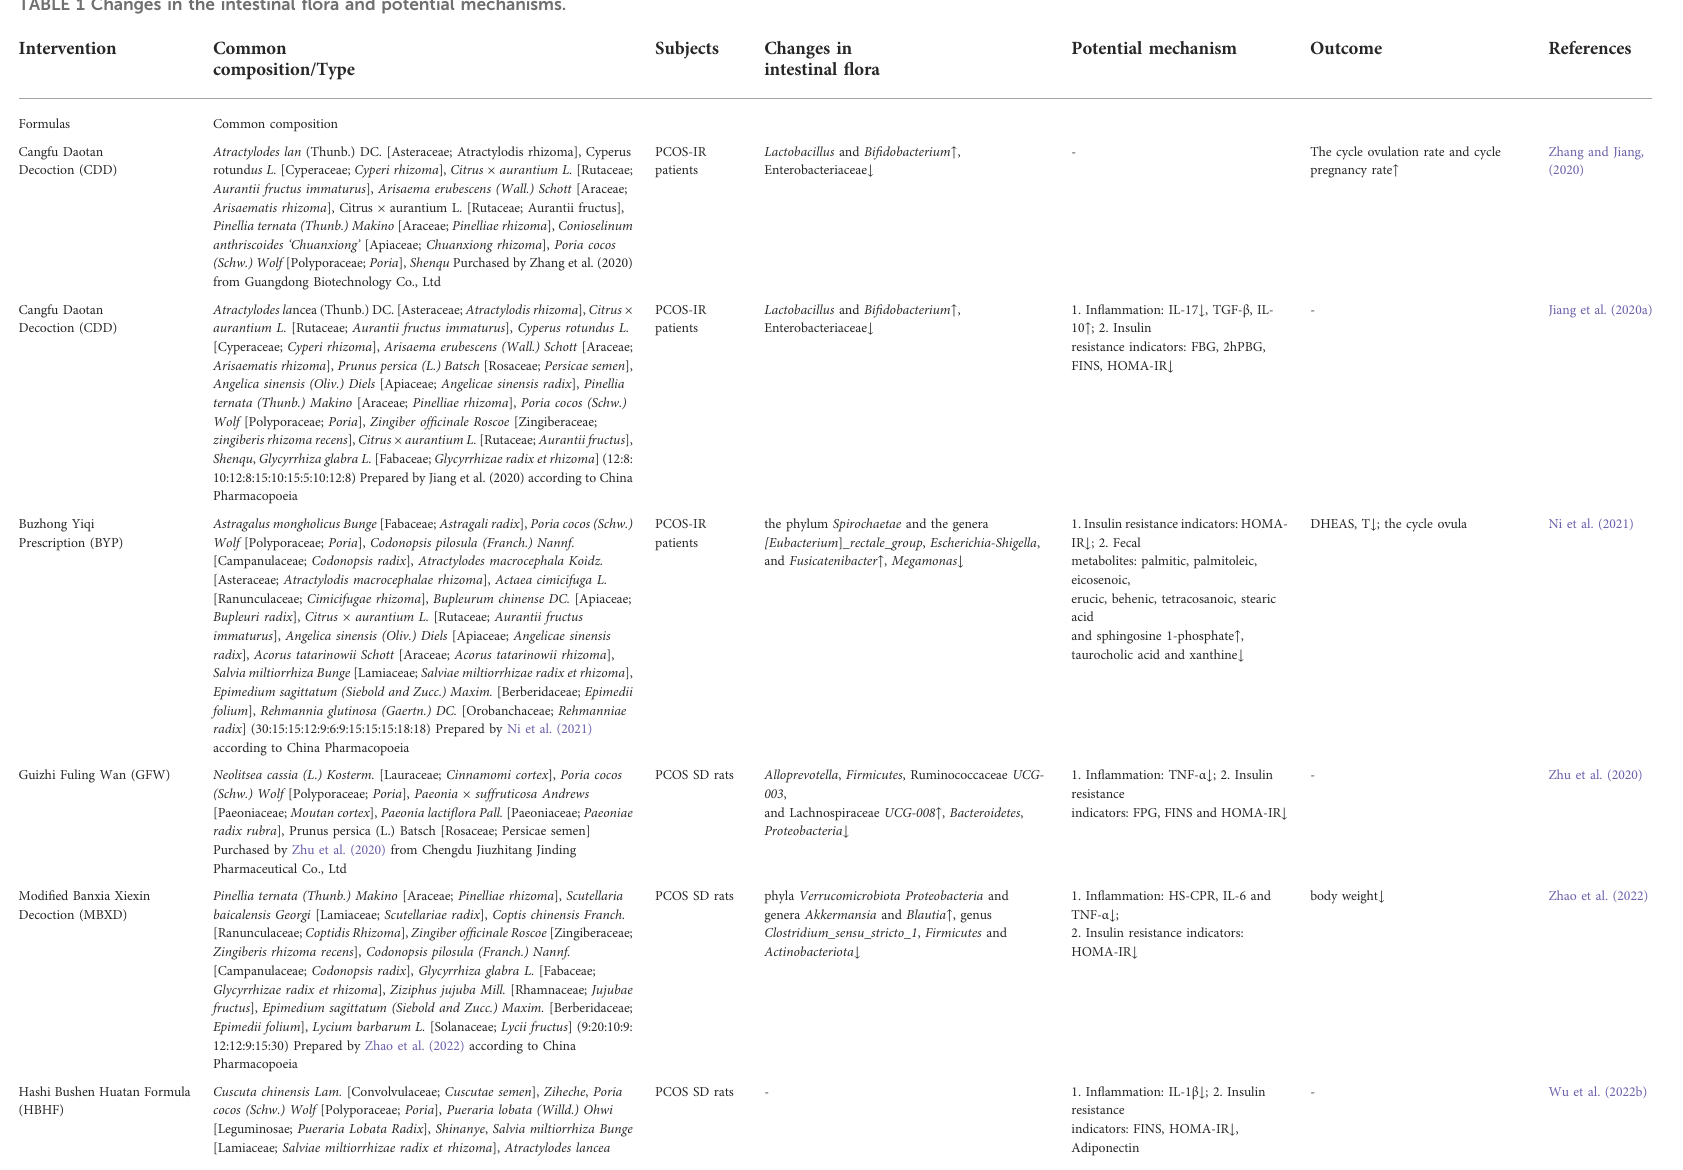
TABLE 1 Changes in the intestinal fl ora and potential mechanisms.